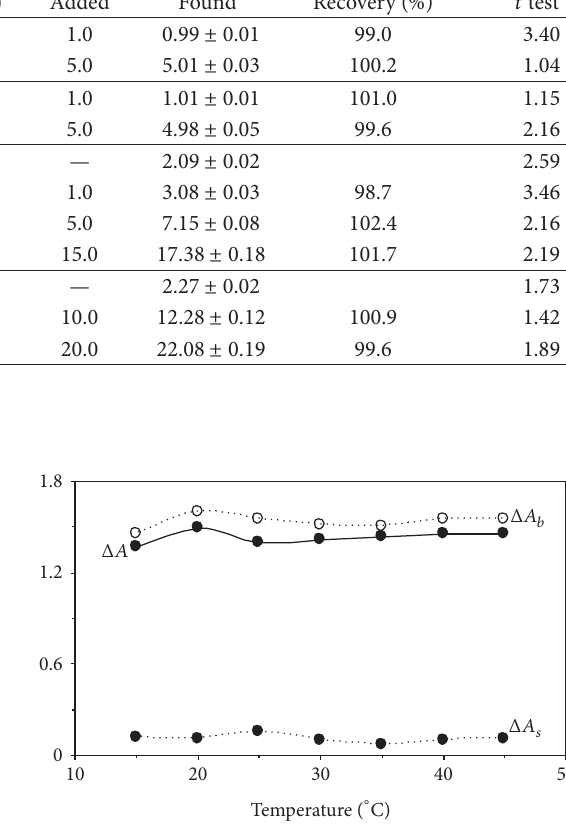
F 5: Effect of temperature on the rate of uninhibited (